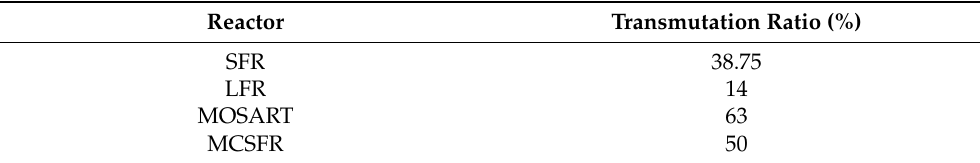
Figure 10. Total TRU-loaded inventory and residual TRU inventory after discharge. The simplified depletion chains of actinides are shown in Figure 11. The inventories of 239 Pu and 241 Pu as fissile materials are depleted to maintain criticality of the reactor. The inventories 237 Np, 240 Pu, and 241 Am decrease because of their large neutron capture cross-sections. The increase in 238 Pu inventory can be attributed to the 237 Np ( n , 𝛾 ) reaction and the 242 Cm 𝛼 decay. Similarly, the increased inventory of 242 Pu is caused by the 241 Pu